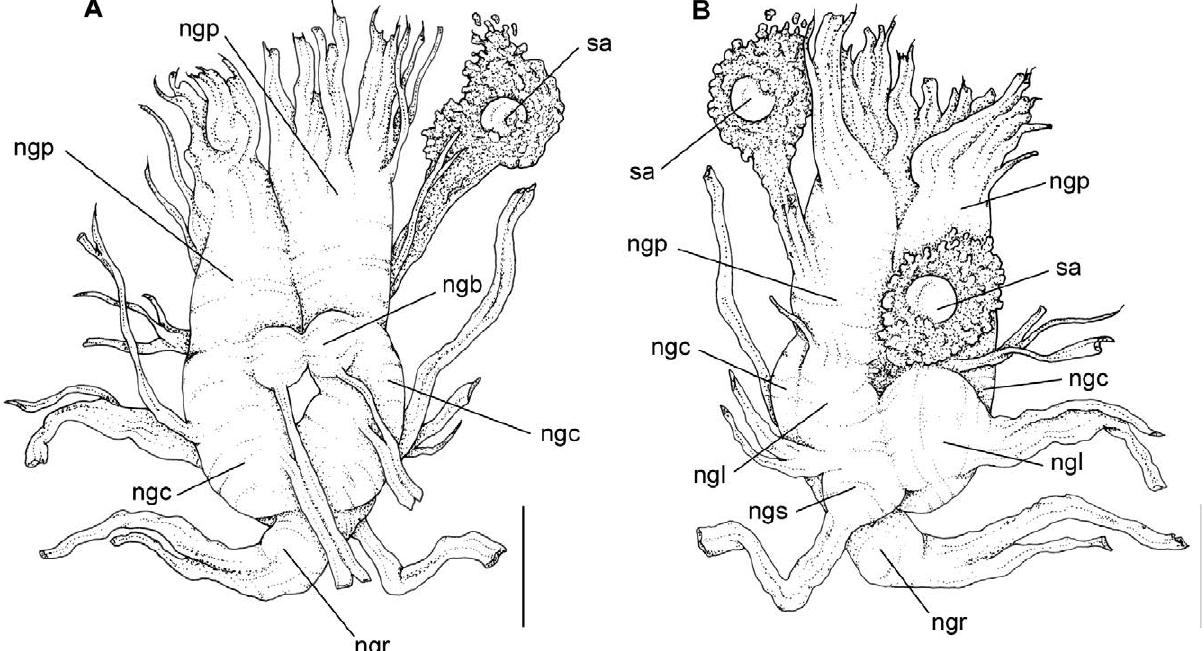
Fig. 5. – Pustulatirus ogum . A, nerve ring in dorsal view; B, nerve ring in ventral view. Abbreviations: ngb, buccal ganglion; ngc, cerebral ganglion; nbl, pleural ganglion; ngp, pedal ganglion; ngr, supra-esophageal ganglion; ngs, subesophageal ganglion; sa, statocyst. Scale bars: 0.5